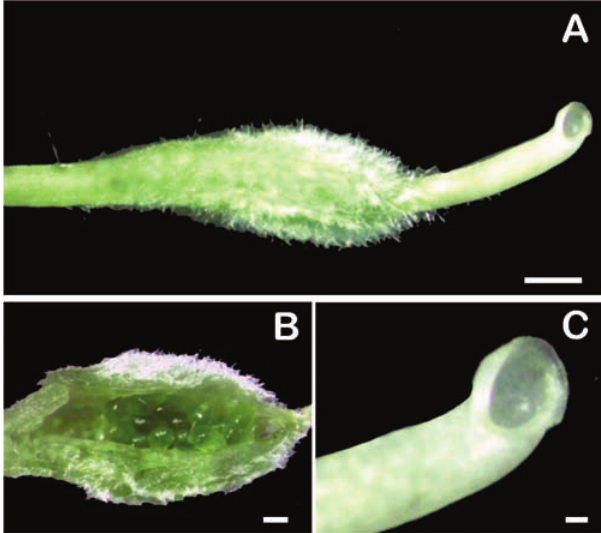
Fig. 2 - Flower development of Moringa oleifera Lam. A, from but- ton flower to anthesis. B, beginning of anthesis. C, anthe- sis; D, flower senescence; E, pod formation. Bar = 1 cm.